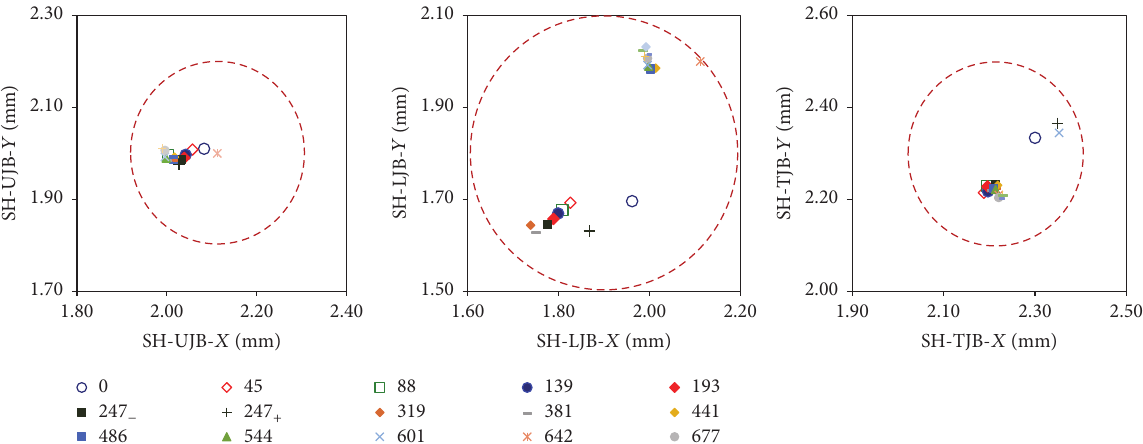
Figure 5: Shaft eccentricity in the upper, lower, and turbine journal bearings of a LHG measured at several loads (from 0 to 763 MW) over a period of 10